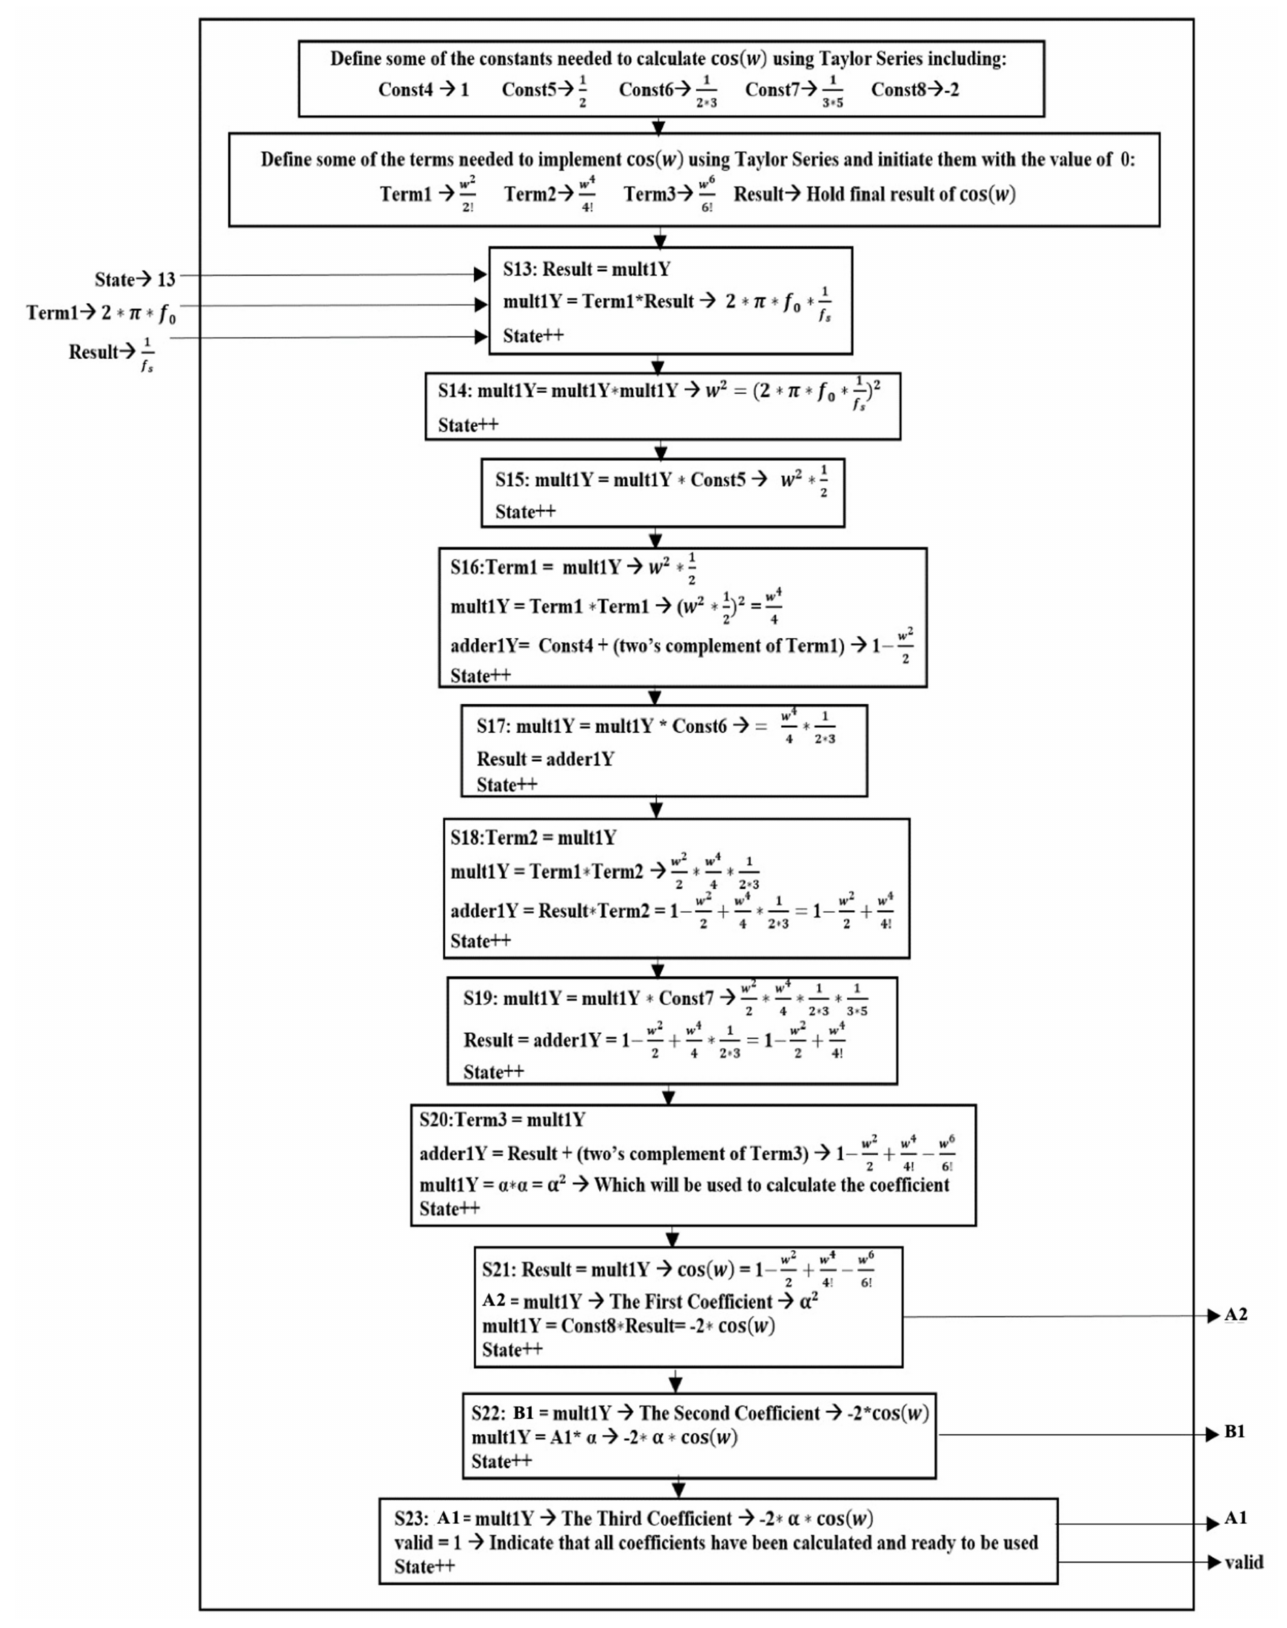
Figure 11. Shared hardware utilized flow to calculate